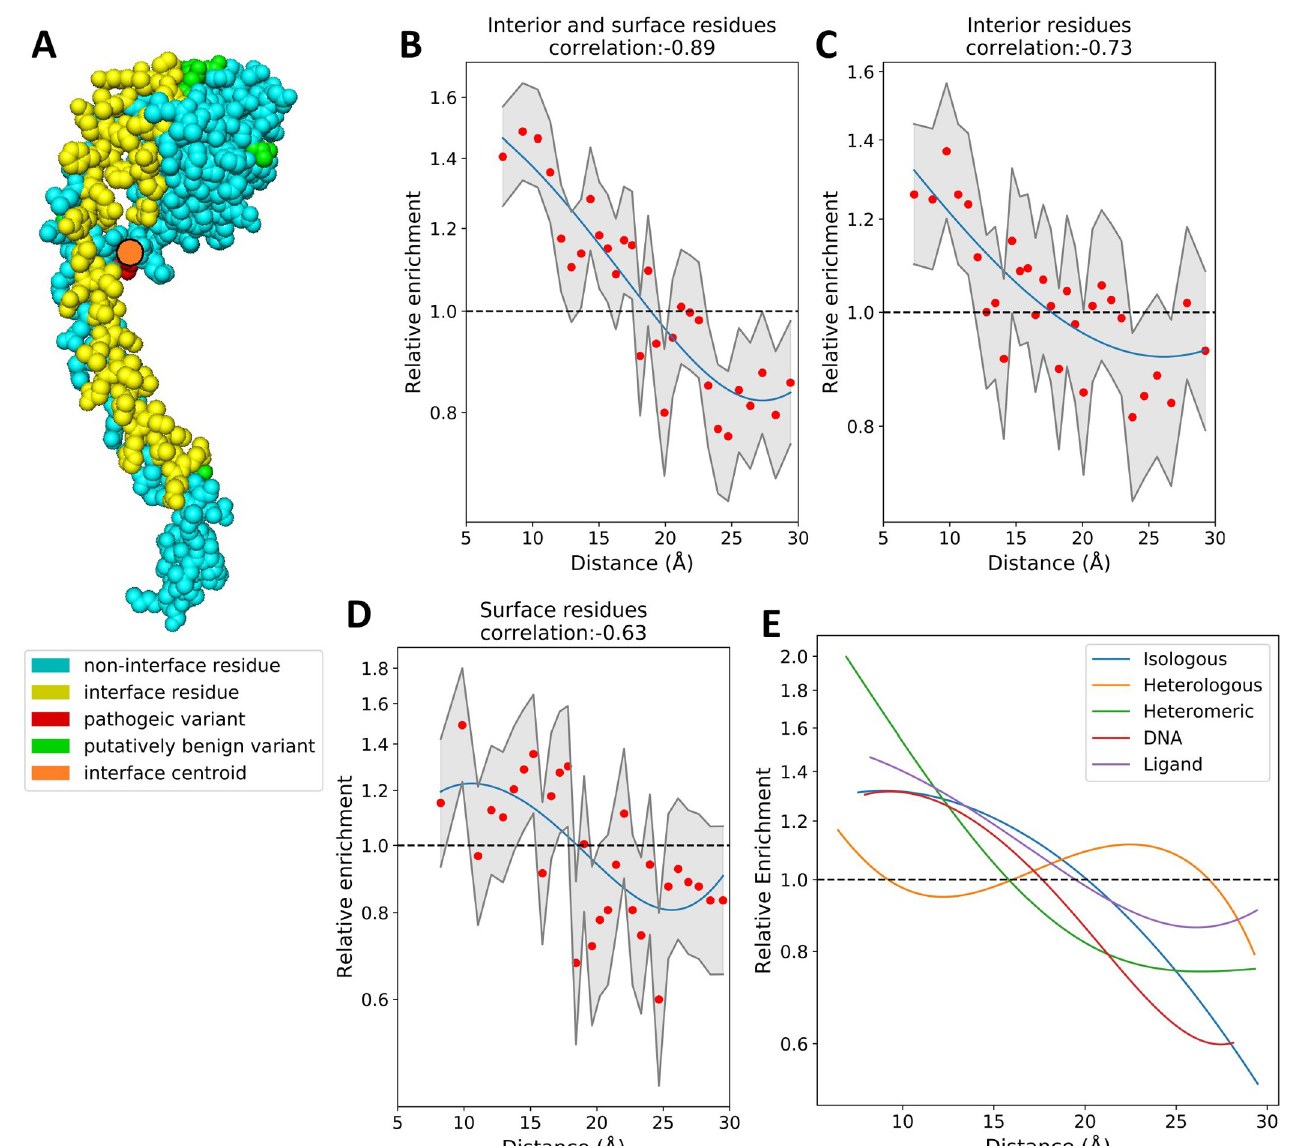
Fig 4. The relationship between interface proximity and disease enrichment. A) Sphere representation of a protein with interface residues highlighted in yellow. The interface centroid is an orange circle. Putatively benign mutations present in gnomAD are shown in green, while pathogenic ClinVar mutations are in red. B-D) Odds ratio of disease mutations at increasing distance from the nearest interface centroid. Confidence intervals (95%) are shown in grey, a univariate spline (blue) has been fit to the data. Charts are shown for surface and interior residues together and individually. E) Overlaid splines fit to odds ratio data of the different protein interface types (taking interior and surface residues